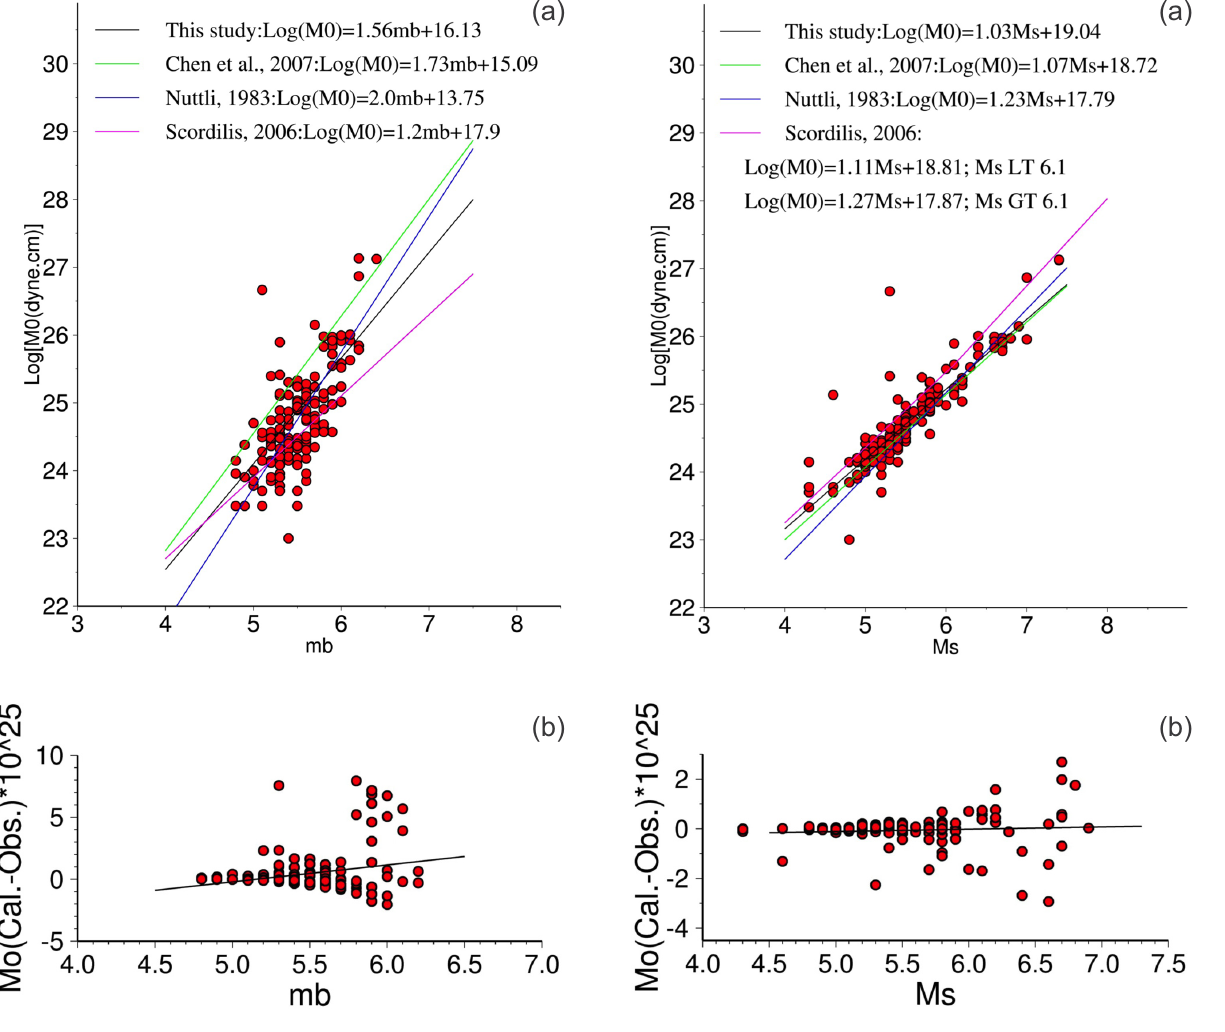
( M ) versus m and related regression line. The black Figure 2. (a) Log b 10 0 line is for this study. Green and blue lines given by Chen et al. [2007] and Nuttli [1983], respectively. (b) Residual diagram for Figure 2a.